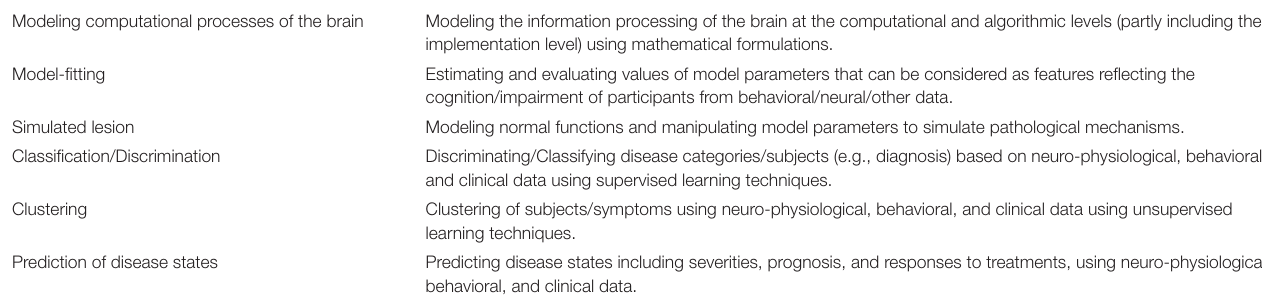
TABLE 1 | Explanation of the tags in the experimental design category. Modeling computational processes of the